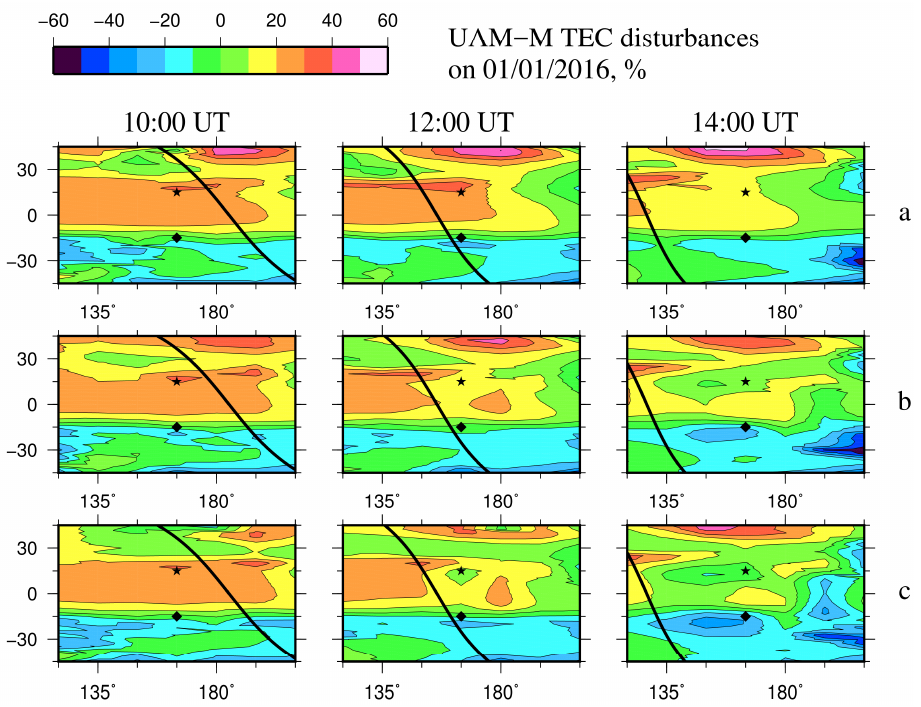
Figure 2. The same as Figure 1, but for the UAM-M (UAM version with the empirical model NRLMSISE-00 for neutral gas) calculations: ( a ) Without currents; ( b ) j s = 20 nA/m 2 ; ( c ) j s = 40 nA/m 2 .